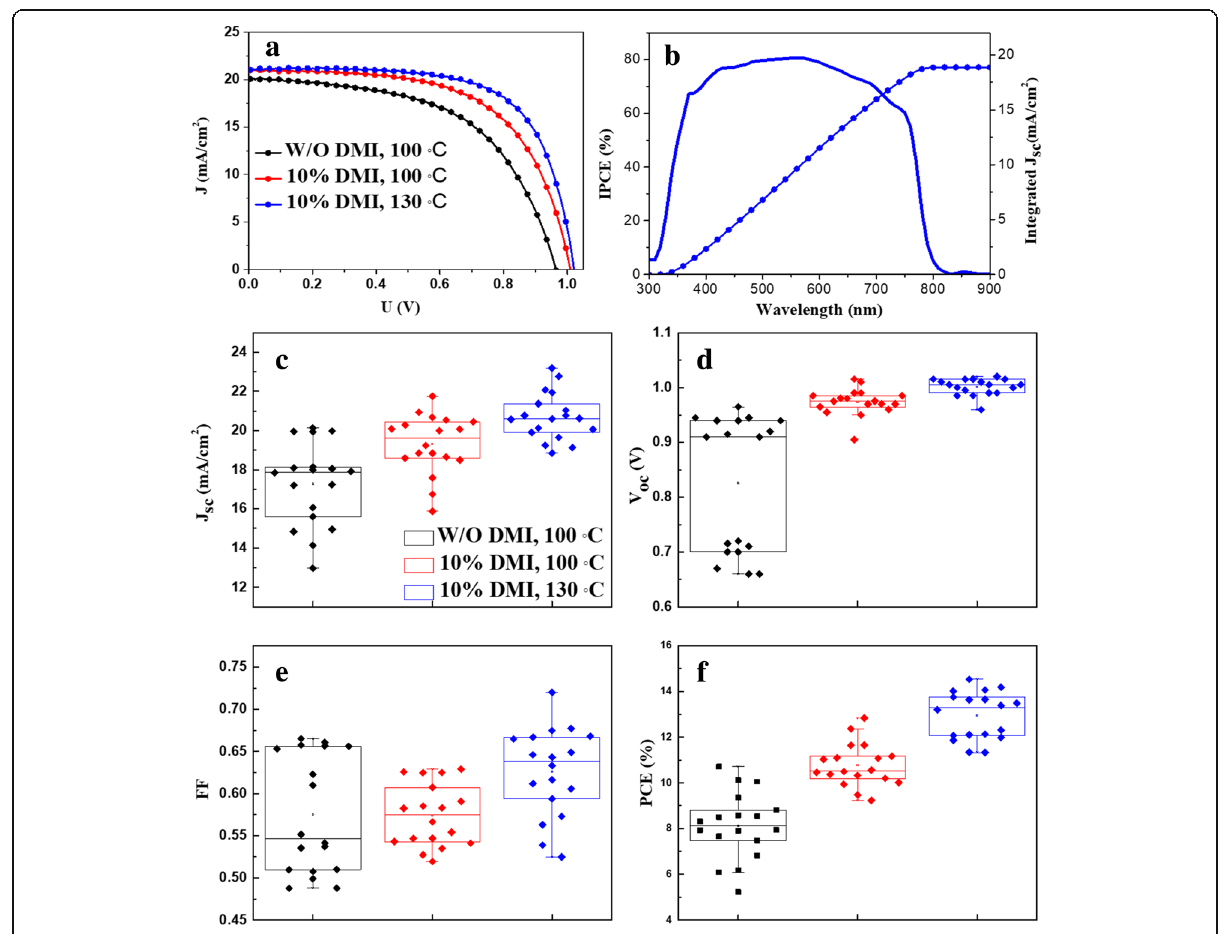
Fig. 4 a J – V curves of the best PSCs fabricated from different conditions. b IPCE spectrum of the best PSCs fabricated from precursor solution adding with 10% DMI and annealing at 130 °C. Box charts of photovoltaic parameters obtained from light J – V curves of a series of PSCs. c J sc , d V oc , e FF, f PCE